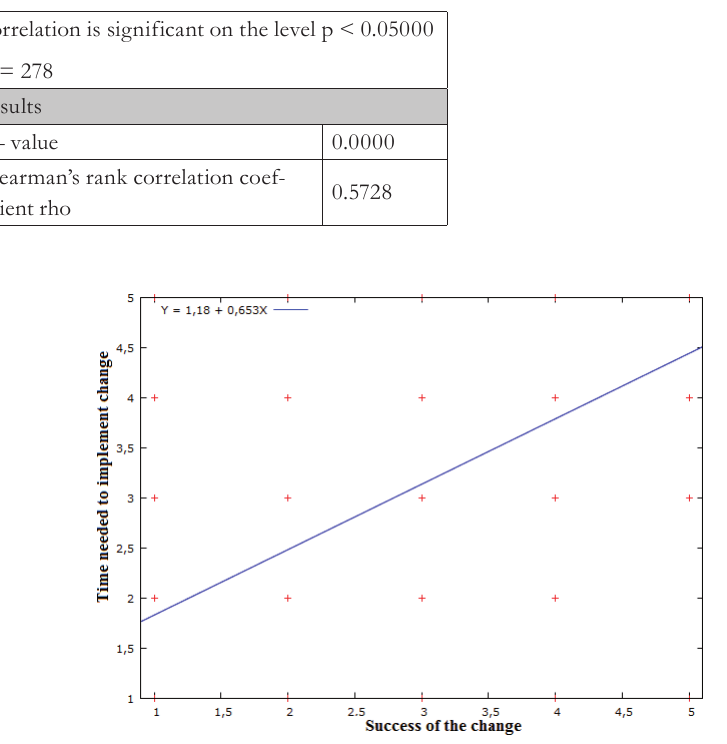
Fig. 3 - X – Y Chart: Testing results of the second hypothesis. Source: own processing using